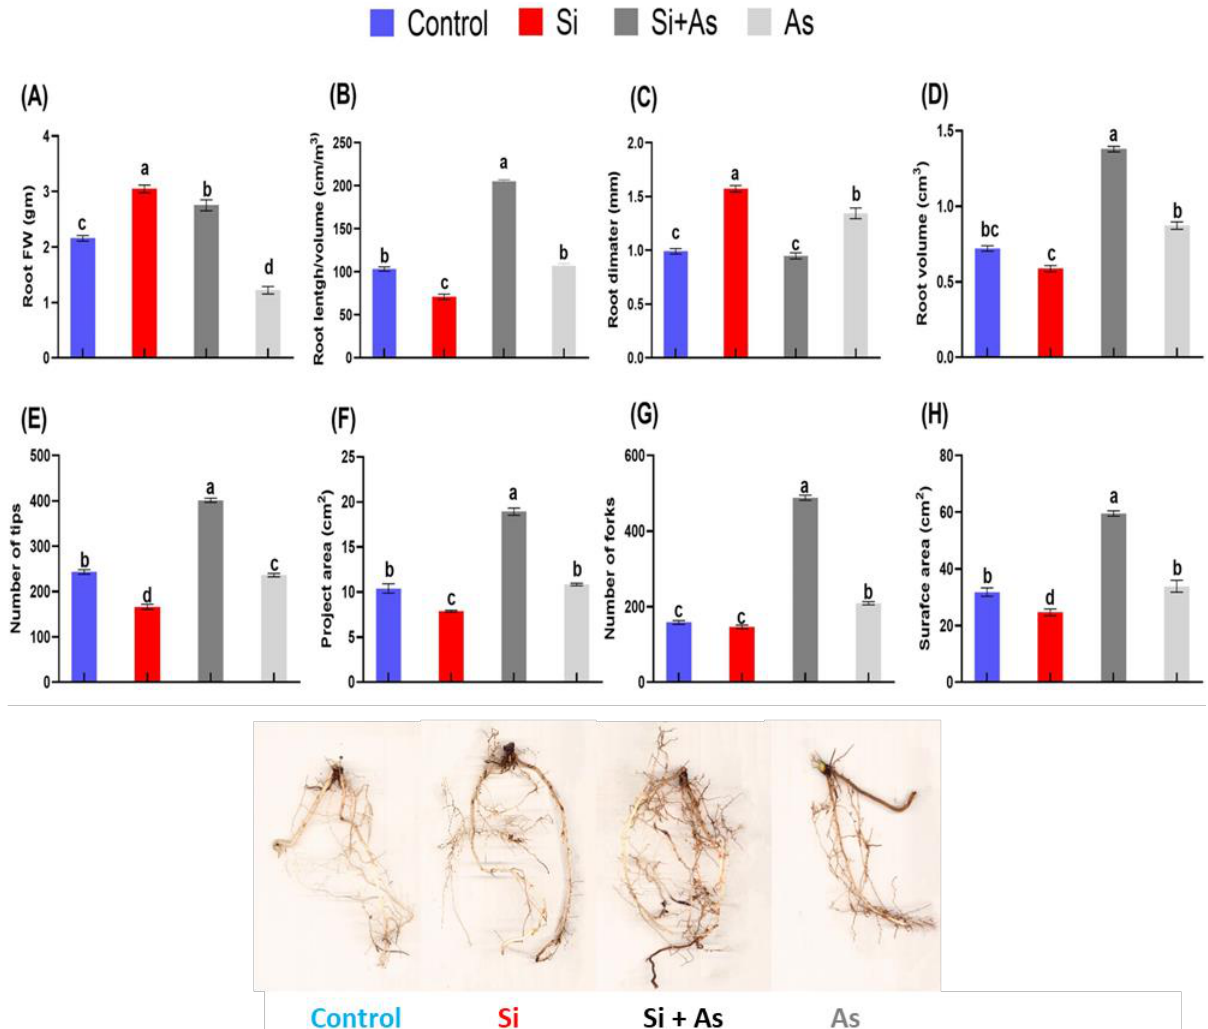
Figure 2. Variations in root architecture of date palm roots exposed to heavy metals stress. ( A ) Root fresh weight, ( B ) root length, ( C ) root diameter, ( D ) root volume, ( E ) number of tips, ( F ) project area, ( G ) number of forks, ( H ) surface area, analyzed with WinRHIZO image analysis system (Regent Instruments, Inc., Sainte-Foy, QC, Canada). Different symbols indicate the values are significantly different ( p < 0.05). Means were analyzed for finding the significant differences among treatments by using Duncan’s multiple range test (DMRT). Values represent means (of 7 replicates) ± standard error.